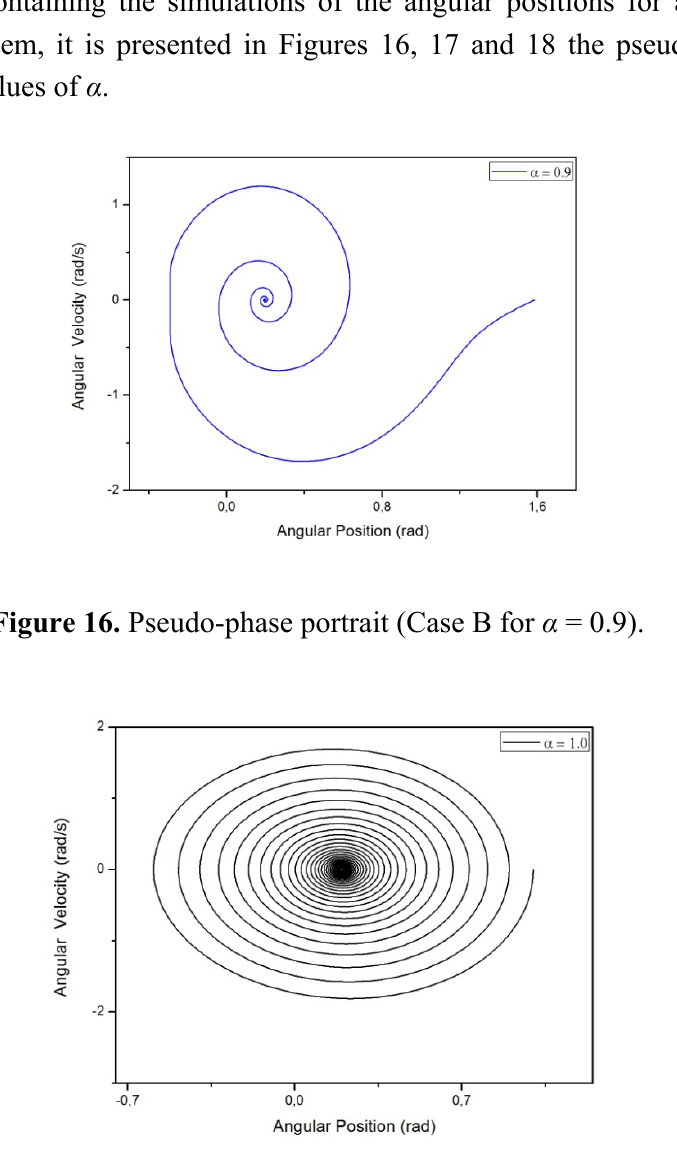
Figure 17. Pseudo-phase portrait (Case B for α =